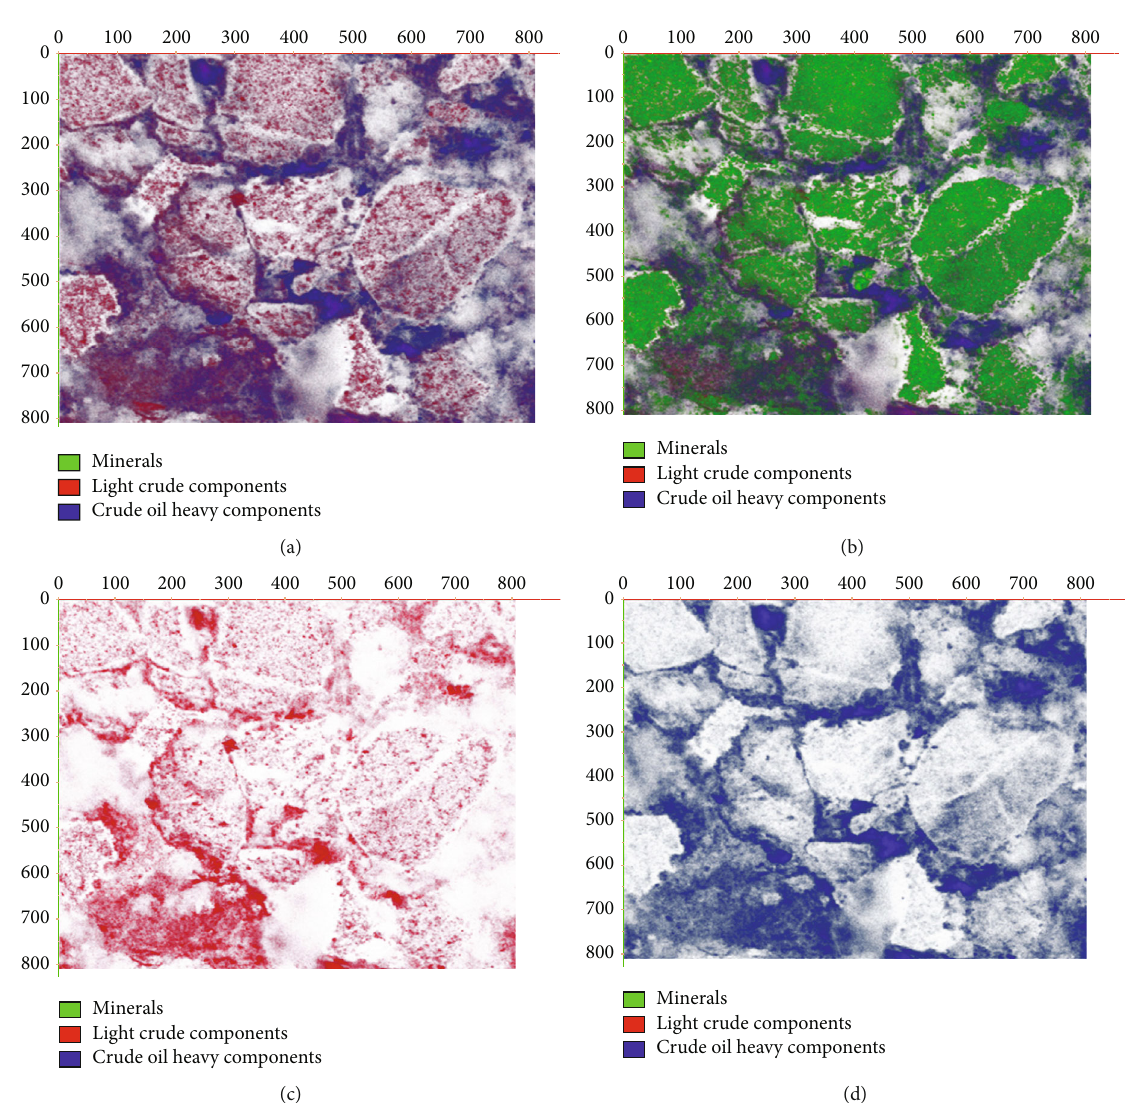
Figure 7: Microscopic light and heavy oil and rock distribution characteristics. (a) Overlay of distribution of light and heavy components in minerals and crude oil. (b) Overlay of distribution of light and heavy components in crude oil. (c) Distribution map of light components of crude oil. (d) Distribution map of heavy components of crude